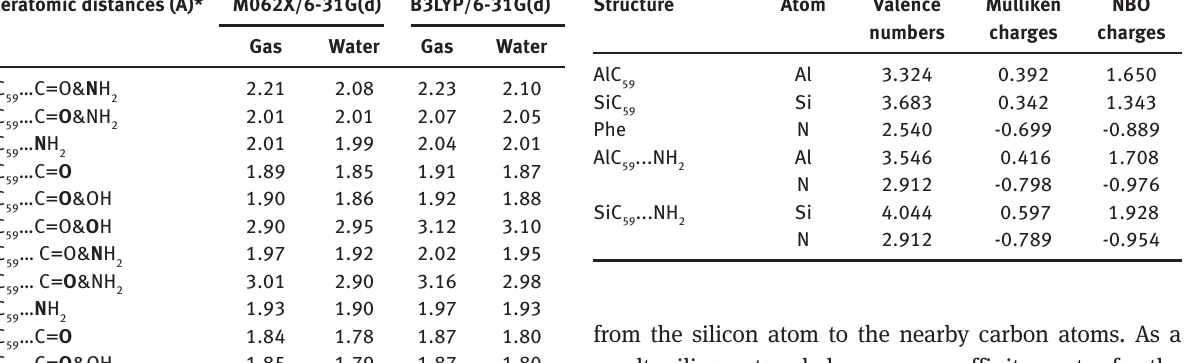
Table 4: Population analysis of the selected systems. Structure